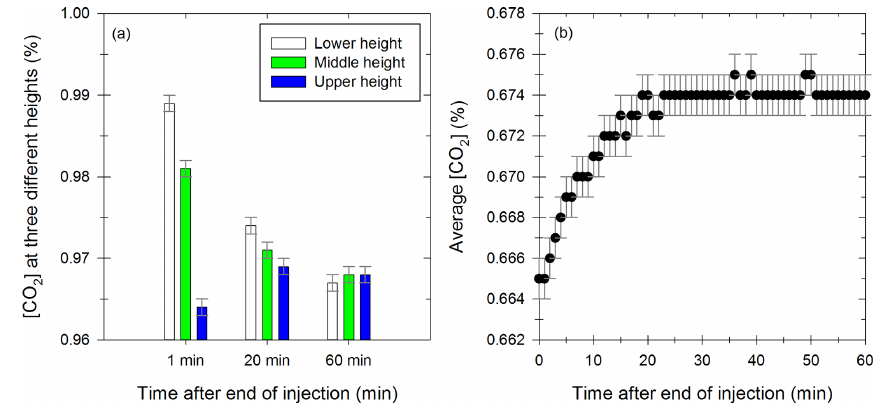
Figure 1. Determination of the mixing time in the chamber, using injection of CO 2 , with measurements of the concentration at three different heights 1, 20 and 60min after injection (a) and with evolution of the average concentration during 60min after injection (b) .